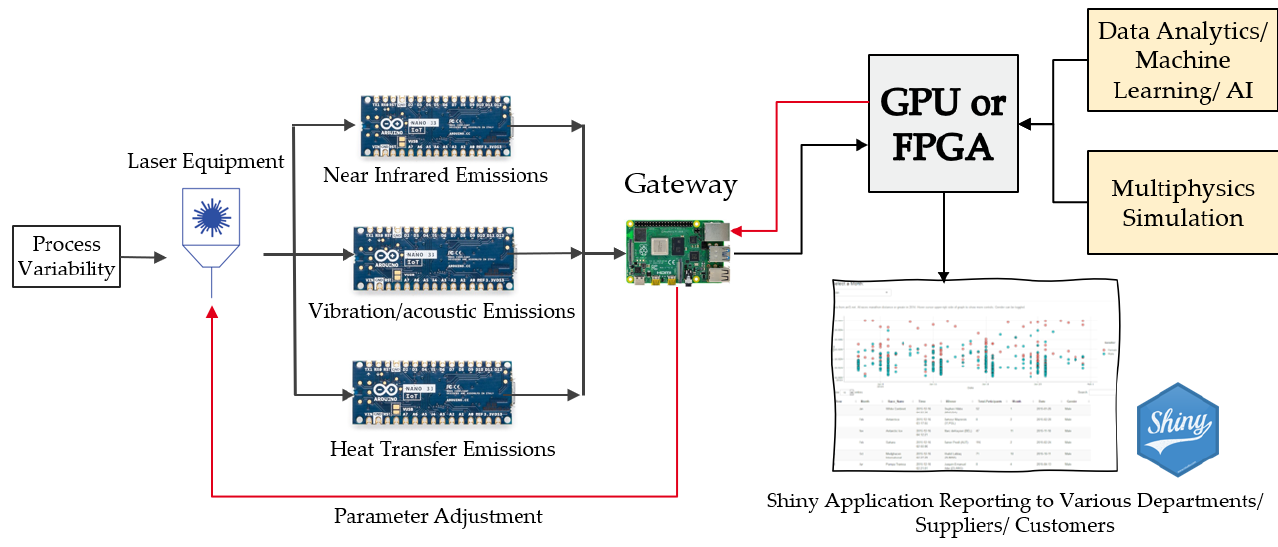
Figure 2. Illustration of the framework for a smart laser micro-welding quality management system further in line with ISO 3834:2021 standards [44,72].